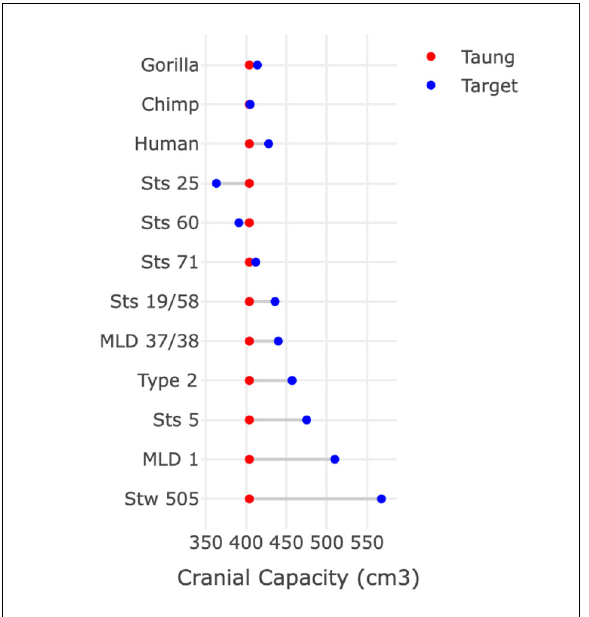
Dumbbell plot showing developmental trajectories necessary to grow a 404-cm 3 Taung cranial capacity to target Australopithecus africanus adult specimens starting at 3.83 years of age. Comparative data for cranial capacity growth in gorillas, chimpanzees and modern humans are presented at the top of the graph. Results for growth